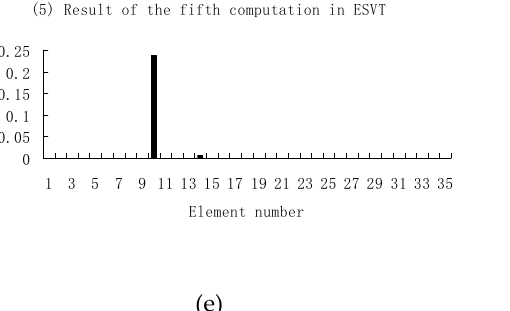
Figure 17. Damage evaluation results of the first to sixth computations in ESVT using the first five frequencies (element 10 had 20% stiffness reduction). ( a ) Result of the first computation in ESVT; ( b ) Result of the second computation in ESVT; ( c ) Result of the third computation in ESVT; ( d ) Result of the fourth computation in ESVT; ( e ) Result of the fifth computation in ESVT; ( f ) Result of the sixth computation in ESVT.